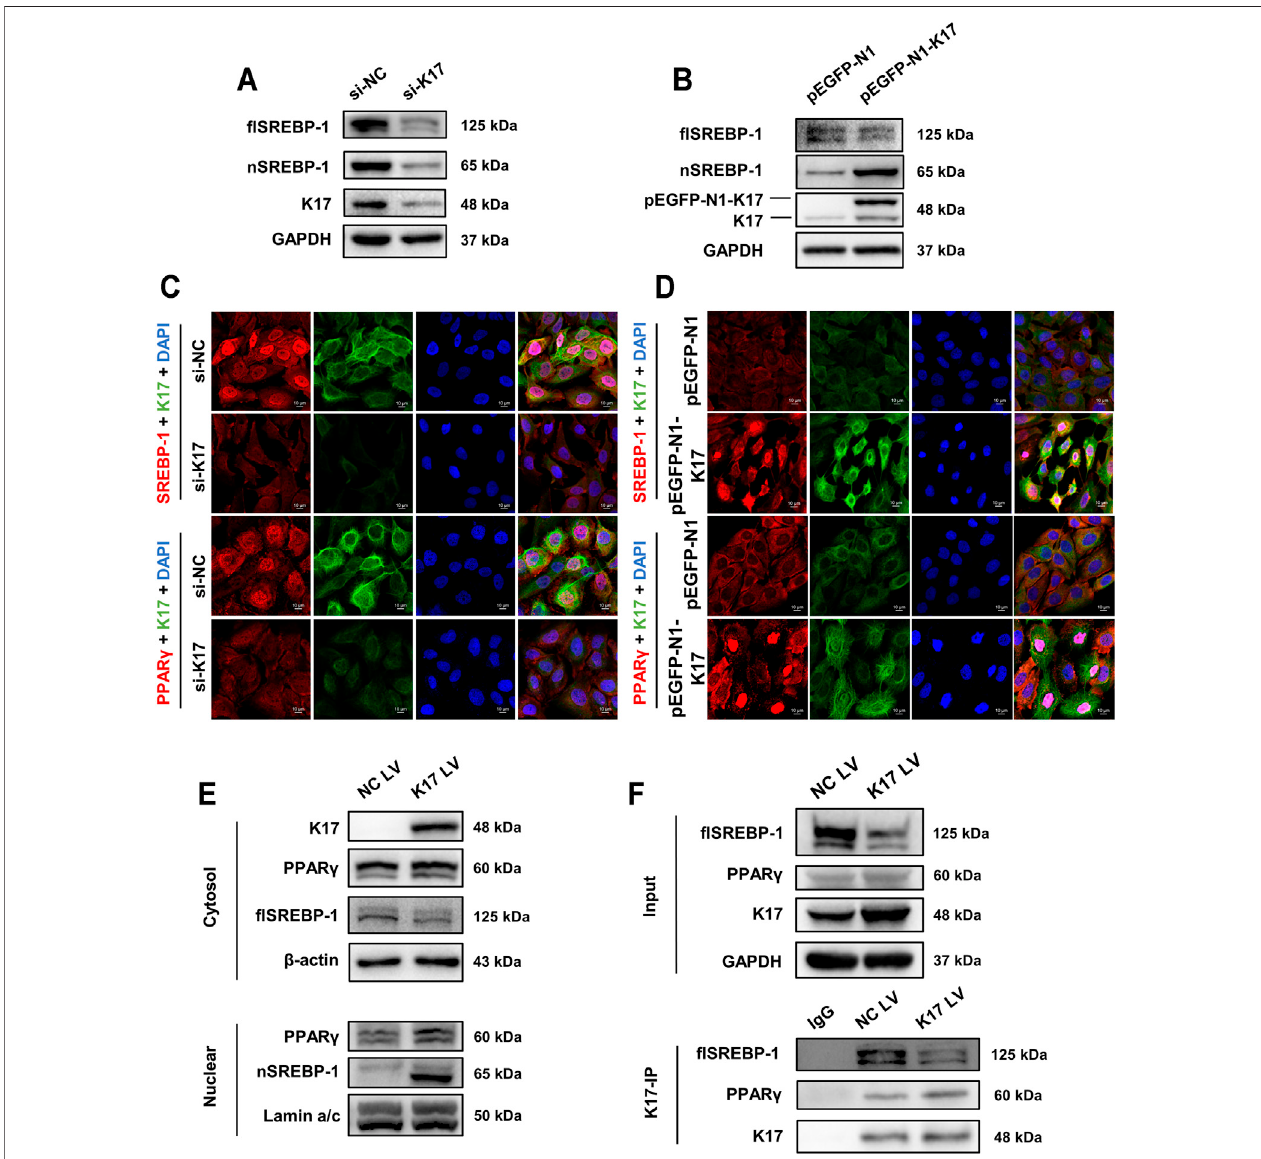
FIGURE 5 | K17 alters the subcellular localization of SREBP-1 and PPAR γ . (A,B) The protein levels of full-length SPEBP-1 ( fl SREBP-1) and nuclear SPEBP-1 (nSREBP-1) in HaCaT cells were measured after transfection with K17 siRNA or pEGFP-N1-K17. (C,D) Immuno fl uorescence analysis of FASN and PPAR γ subcellular localizationinHaCaTcellsaftertransfectionwithK17siRNAorpEGFP-N1-K17.Scalebars (cid:1) 10 μ m. (E) HaCaTcellsweretreatedwithpCMV6-XL5-K17(K17LV)anda nuclearfractionwasprepared.SREBP-1andPPAR γ proteinwasquantitatedbyWesternblot.LaminA/Cand β -actinwereusedasloadingcontrolsfornuclearand cytosolfractions,respectively. (F) Cellswereco-immunoprecipitatedwithanti-K17antibodyandSREBP-1andPPAR γ proteinsweredetectedbyWesternblot.Dataare expressed as means ± standard error of the mean from three independent experiments. * p < 0.05.